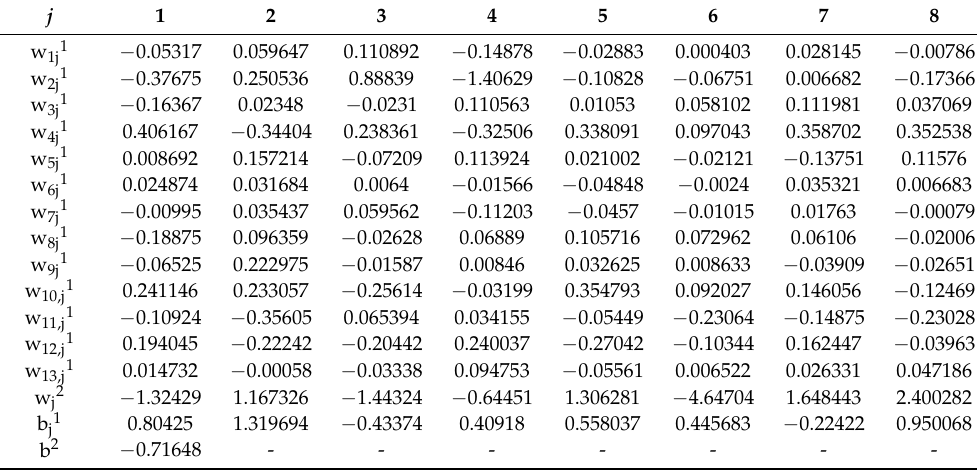
Table 4. Values of the weights and biases in the network.